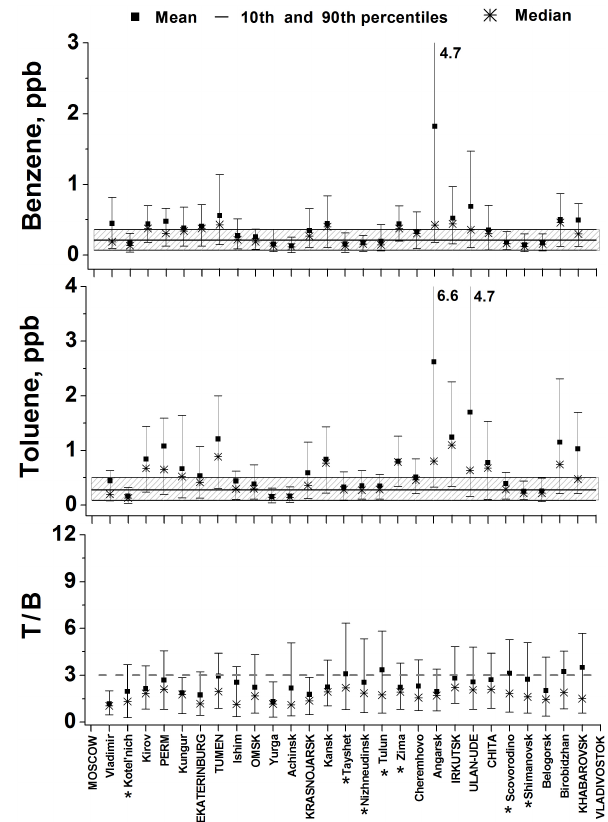
Figure 5. Benzene, toluene and T / B in Russian cities along the Trans-Siberian Railway. The cities with a population from 250000 to 1 million or more are shown in capital letters, and the cities with a population from 50000 to 250000 in lowercase. Asterisks show cities with a population less than 50000. The cities are shown in accordance with their location along the railway. The shaded area represents the mean, 10th and 90th percentiles calculated from the data measured in rural regions. The dotted line is a border between vehicle and industrial exhausts (Mugica et al., 2003; Tiwari et al., 2010; Carballo-Pat, 2014; Shaw et al.,